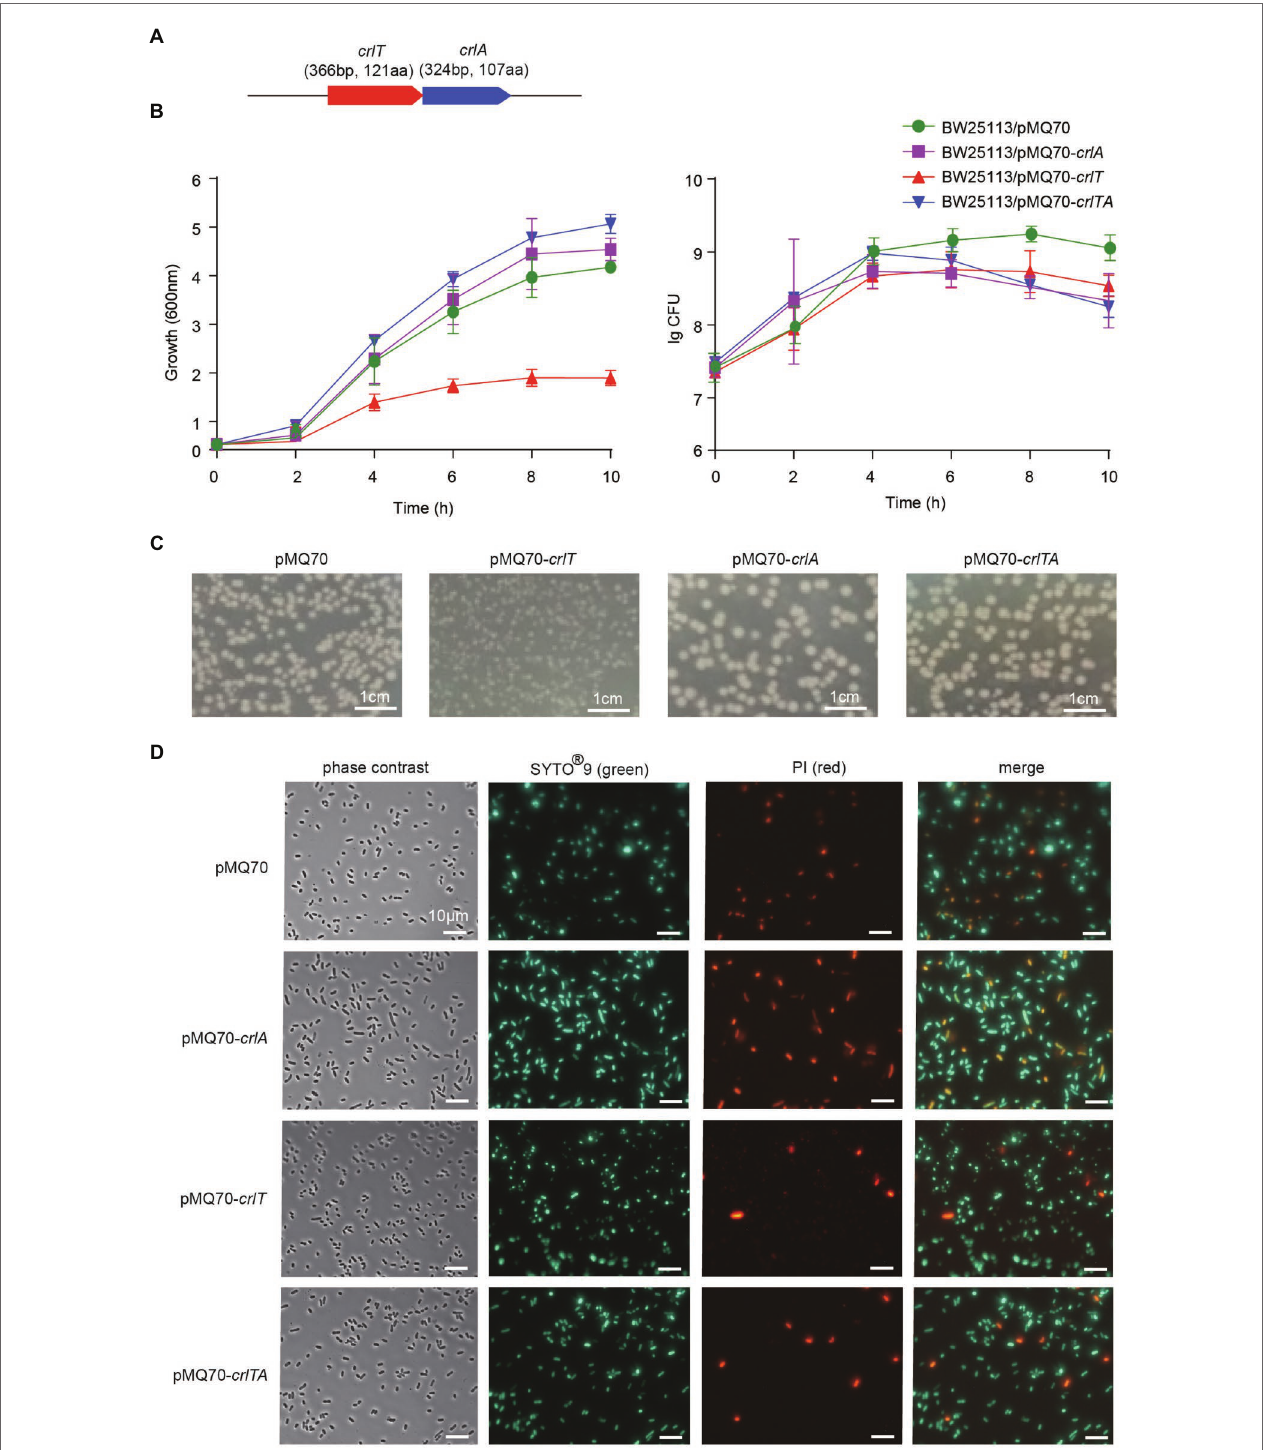
FIGURE 1 | CrlT is toxic and CrlA neutralizes the toxicity of CrlT. (A) The crlTA locus in P. aeruginosa WK172. (B) Growth of the E. coli BW25113 strains harboring the pMQ70-based plasmids was induced with 10 mM arabinose at OD600 ∼ 0.1. Cell viability (CFUs/ml) was determined at the time points indicated. Error bars indicate the standard error of the mean ( n = 3) in (B) . (C) E. coli BW25113 hosts harboring pMQ70-based plasmids were streaked on LB plates supplemented with 100 μ g/ml carbenicillin with or without 20 mM arabinose. Plates were photographed after grow for 24 h. (D) Live/dead staining was performed (live cells appear green, and dead cells appear red/yellow). E. coli BW25113 hosts harboring pMQ70-based plasmids were cultivated in LB supplemented with 100 μ g/ml carbenicillin and 10 mM arabinose for 4 h. Three replicates were used, and only representative figures are shown in (C,D)